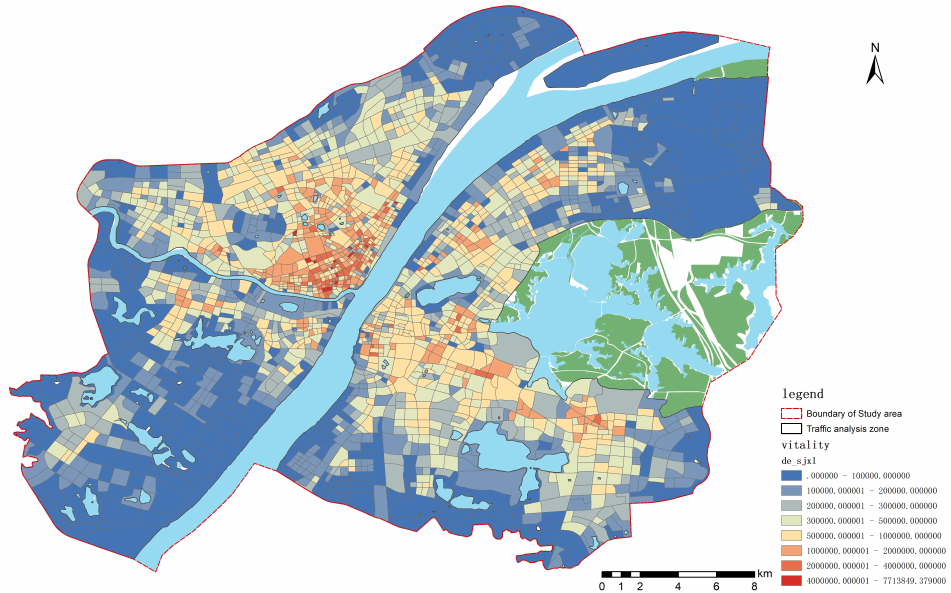
Figure 17. Block week vitality spatial distribution.